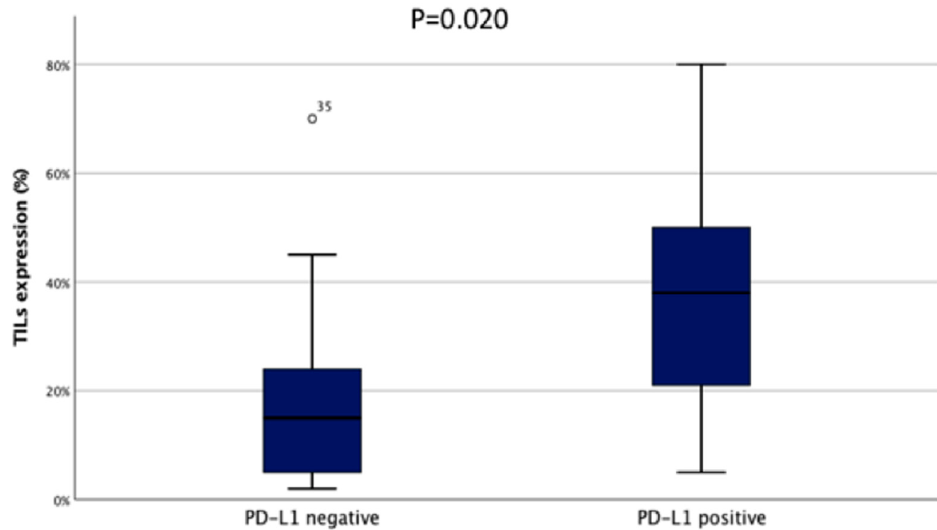
Table 5. Association between age, Ki67, cT, cN, TIP, and